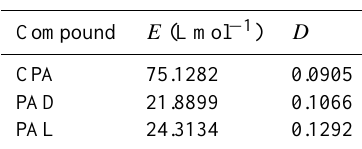
Table 4. Szyszkowski parameters E and D for the three model HULIS compounds.